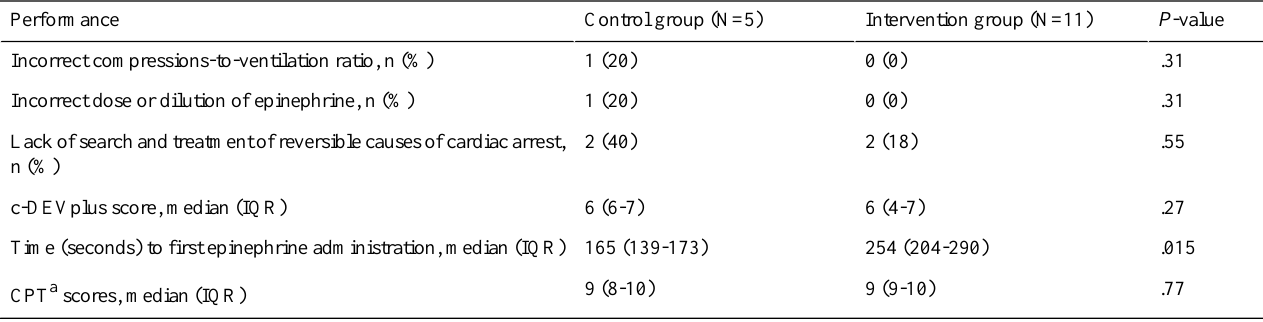
Table 2. Resuscitation performance of the